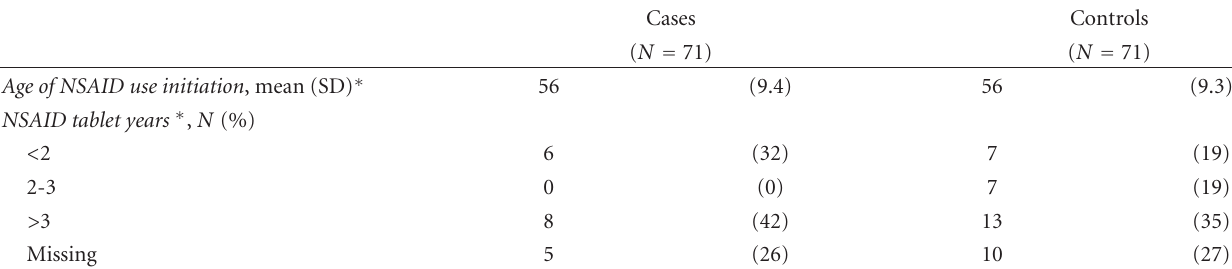
Table 2: Characteristics of cases and controls by NSAID use. Number (percentage) is shown unless otherwise indicated. Cases